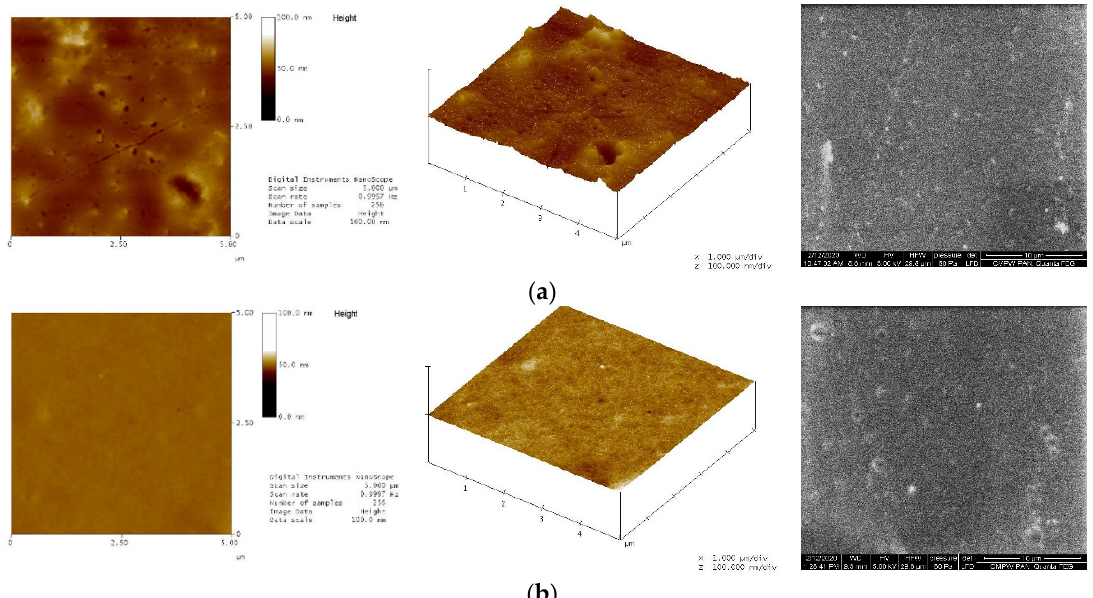
Figure 3. AFM and SEM micrographs of Film 2: ( a ) in the dry state; and ( b ) after incubation in water at 40 °C.